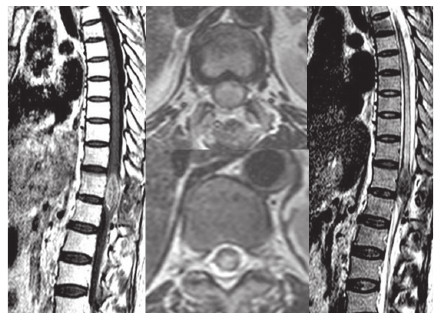
Figure 1: Spinal MRIshowed an intramedullary and highly gadolin- ium enhancing lesion with regular borders.